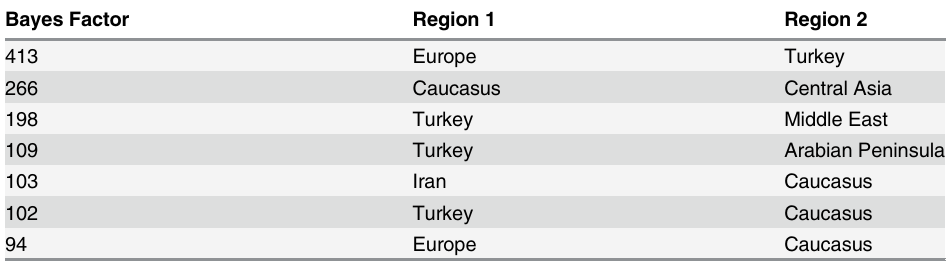
Table 3. Signi fi cant migration events among regional groupings in the Middle